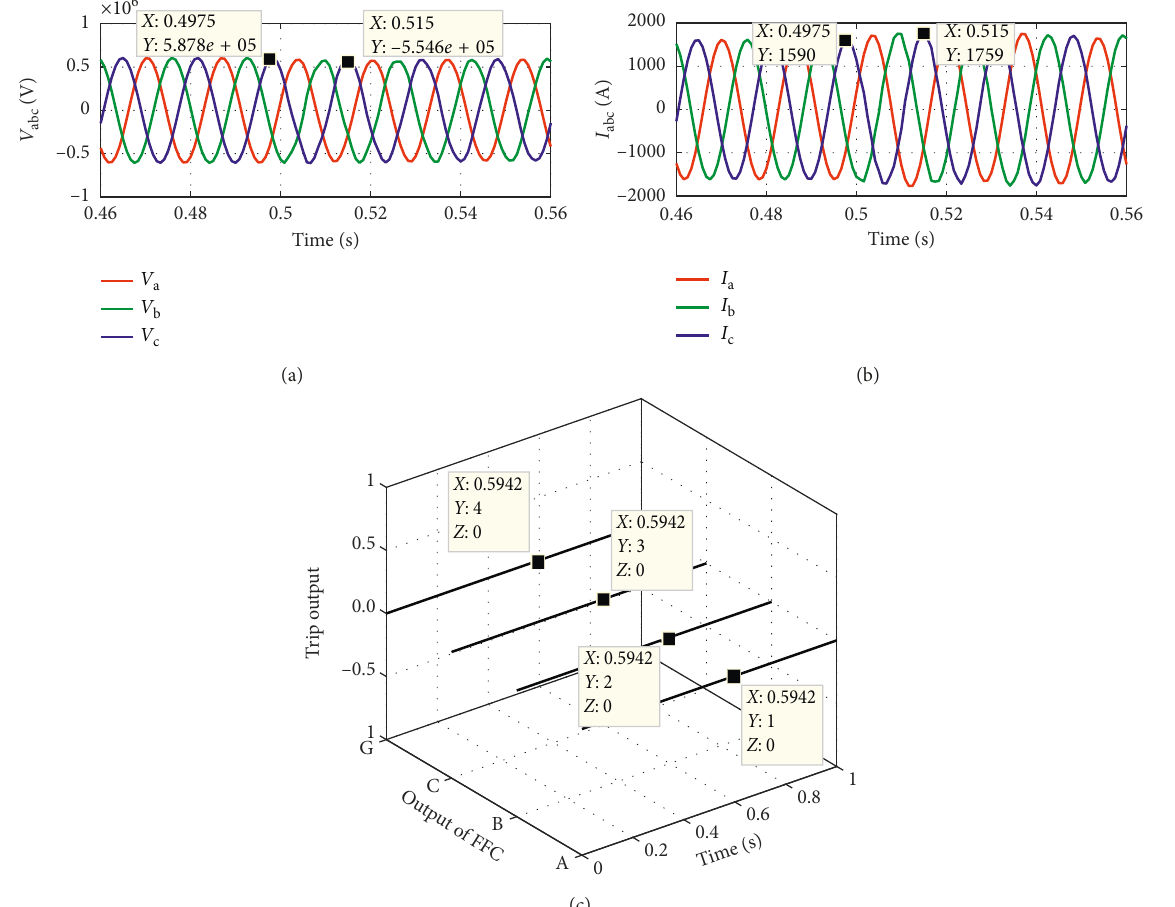
Figure 11: Performance during heavy load condition at 300km, P phase current waveform; (c) output of